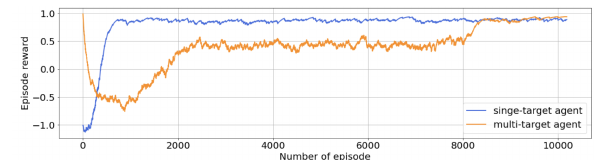
Figure 5. Training curves tracking the agent’s episode reward.